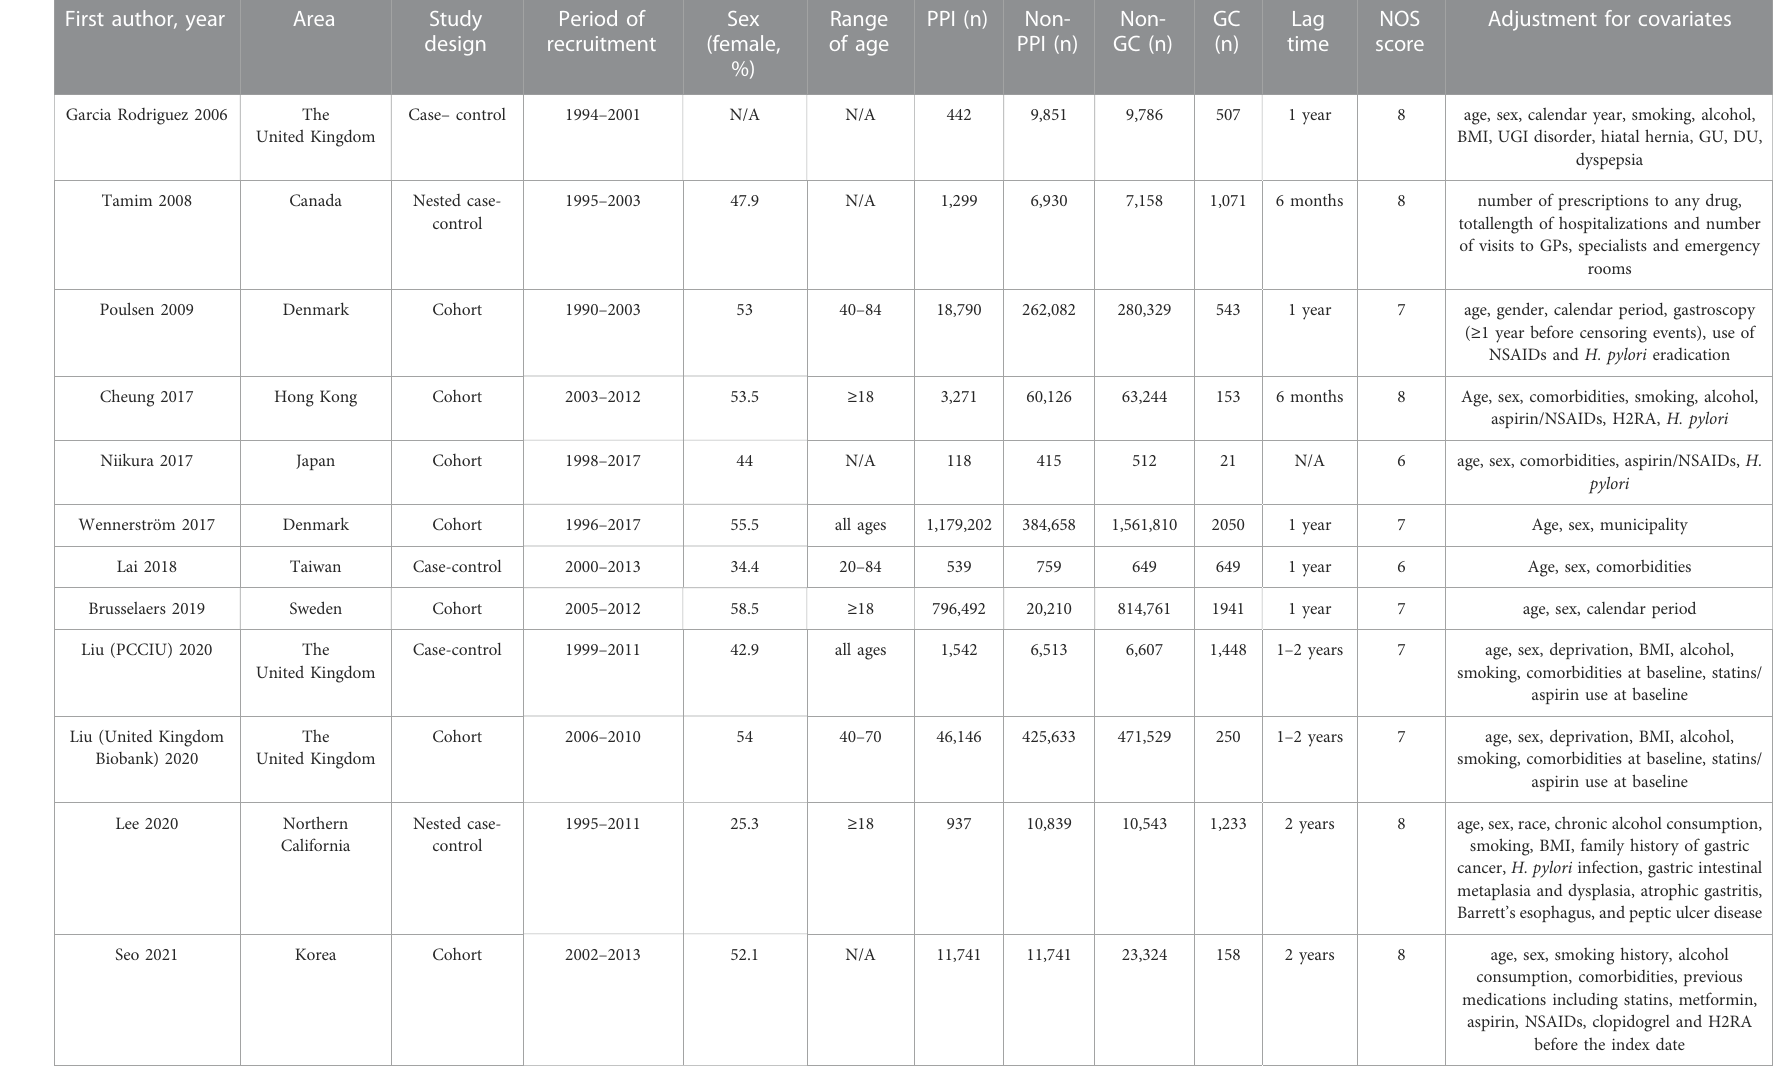
TABLE 1 Characteristics of the included studies on the use of PPI and risks of Gastric